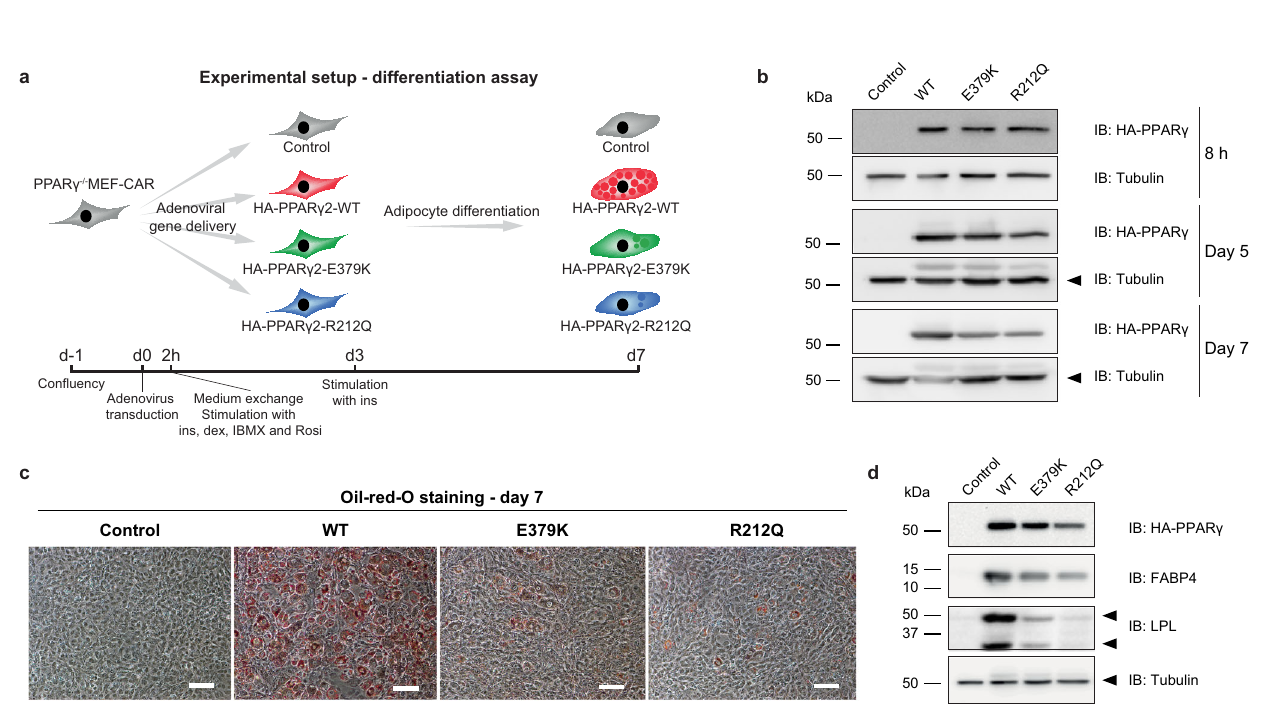
Fig. 4 | E379K and R212Q impair the adipogenic capacity of PPAR γ 2. a Experimental outline showing the timing of the transduction of PPAR γ − / − MEF- CAR cells with adenovirus containing HA-tagged PPAR γ 2-WT or mutants, and treatment of the transduced cells with the differentiation cocktails (2h-day 3: insulin, dexamethasone, isobutylmethylxanthine, and rosiglitazone, day 3 – 7: insulin). b Western blot assessing the expression of WT and mutant PPAR γ 2 at the timepoints 8h, day 5 and day 7 after adenoviral transduction. The membrane was probed with antibodies against HA-tagged PPAR γ and Tubulin (internal control). Three independent experiments were performed, and similar results were